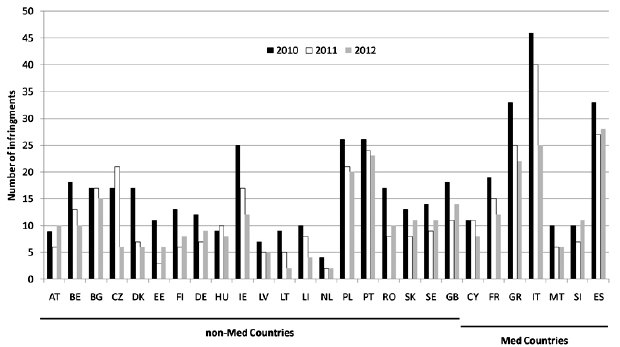
Fig. 3 . Statistics on environmental infringements in European Countries (ISO 3166-2 Codes) for the years 2010, 2011, and 2012 (EC 2013 c